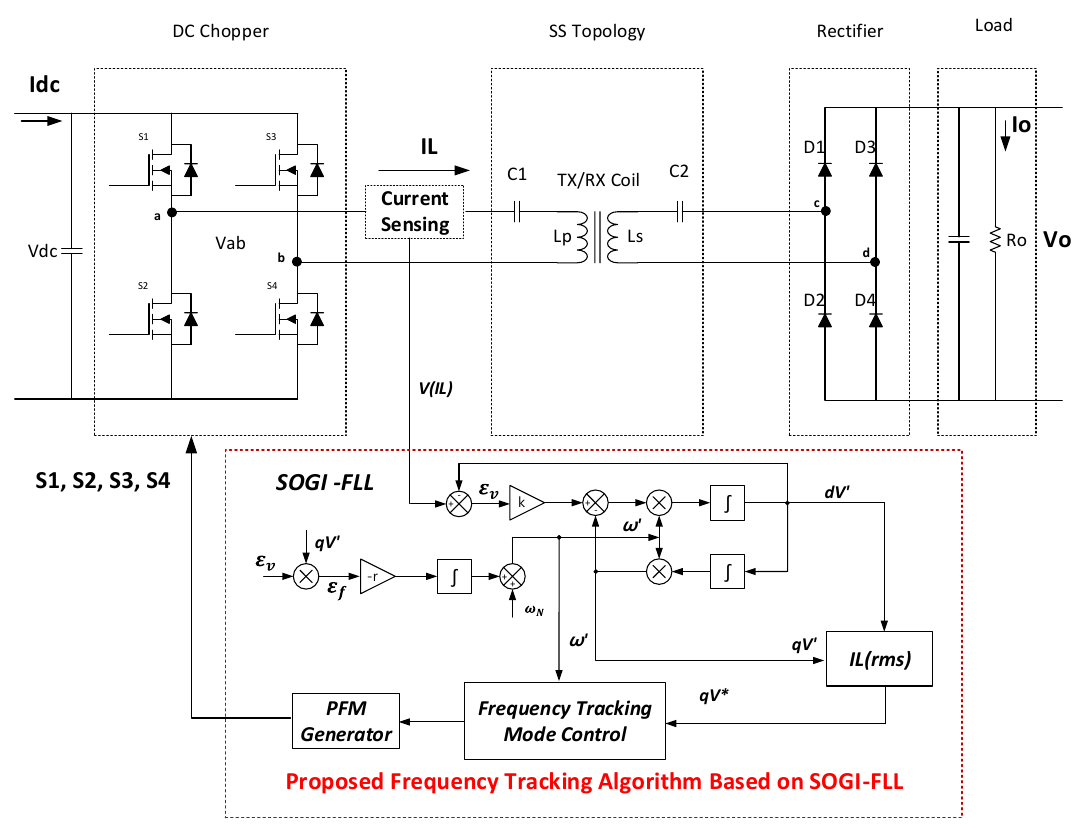
Figure 5. Proposed wireless power transfer (WPT) system diagram.